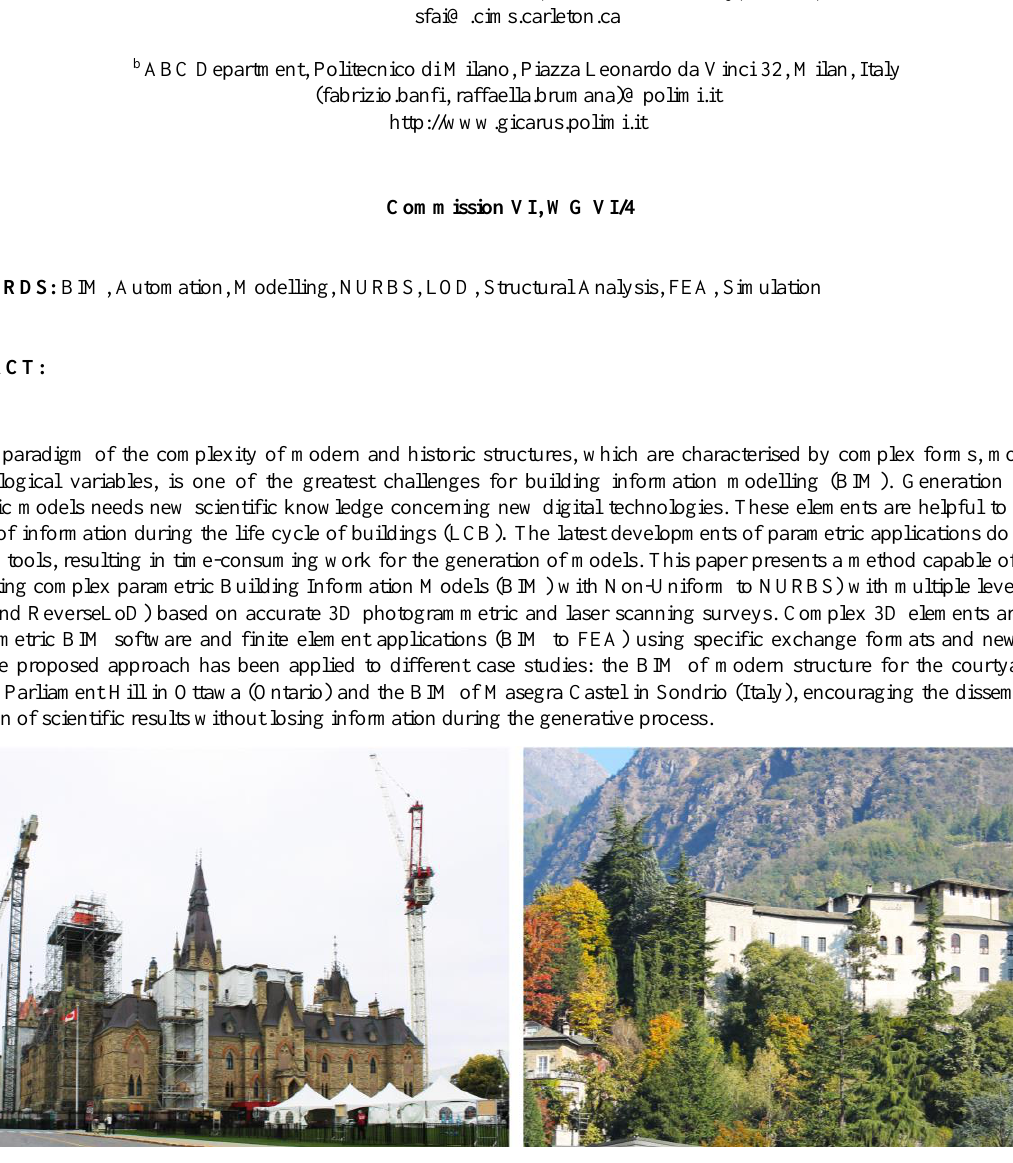
Fig. 1. West Block on Parliament Hill in Ottawa, (Ontario XIX century ) and Masegra Castel in Sondrio (Italy, XIV